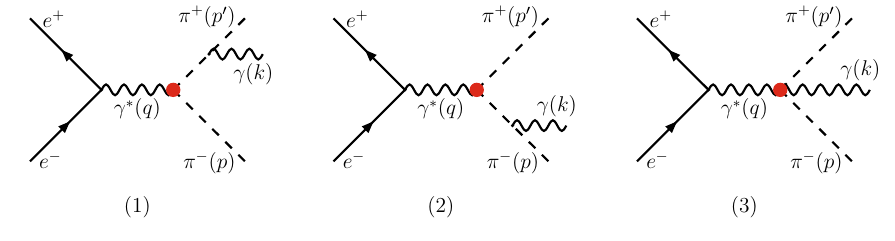
Fig. 5 FSR Feynman